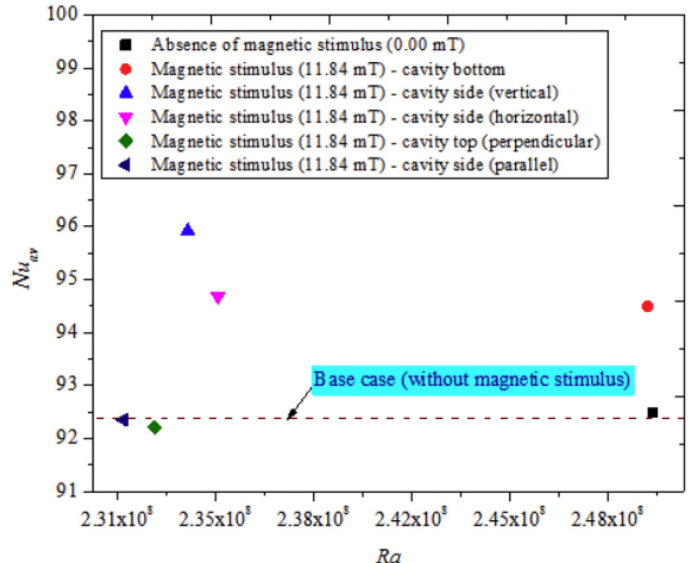
Figure 25. Variation of magnetic stimulus with Nu av for different cavity walls. Reprinted with permission from Ref. [46]. 2020, Elsevier.